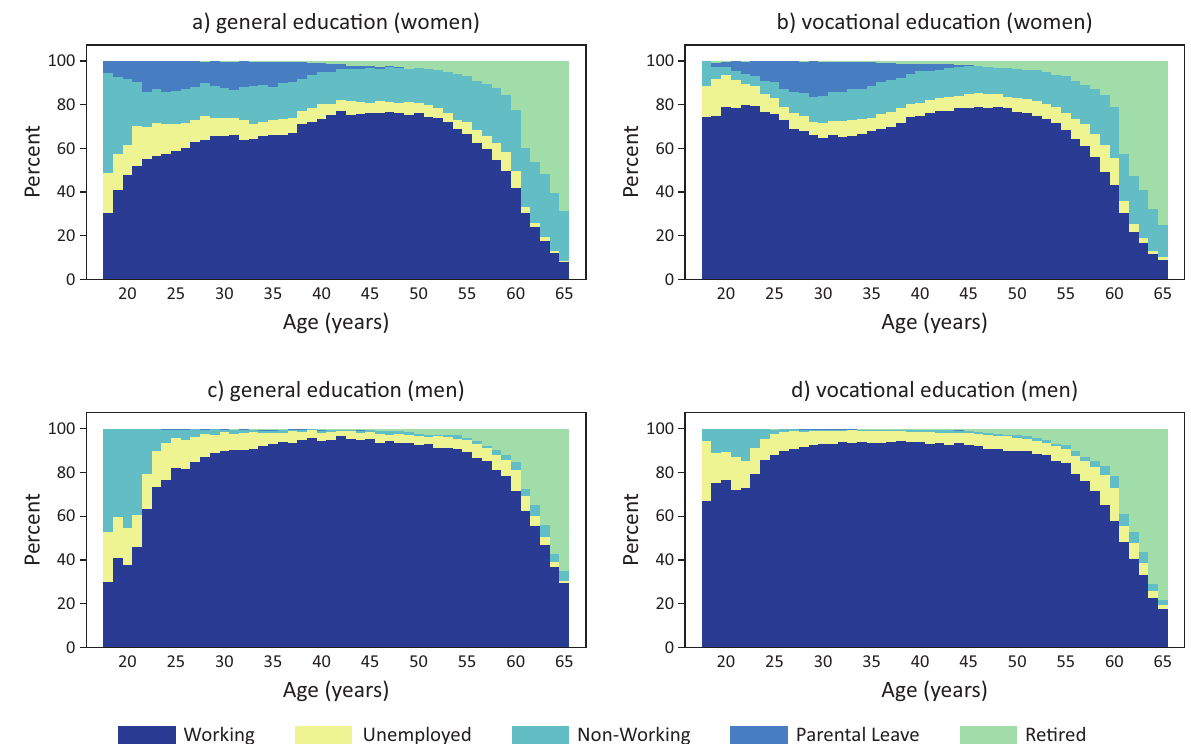
Figure 3. Employment status by education type, age, and gender. Data source: GSOEP